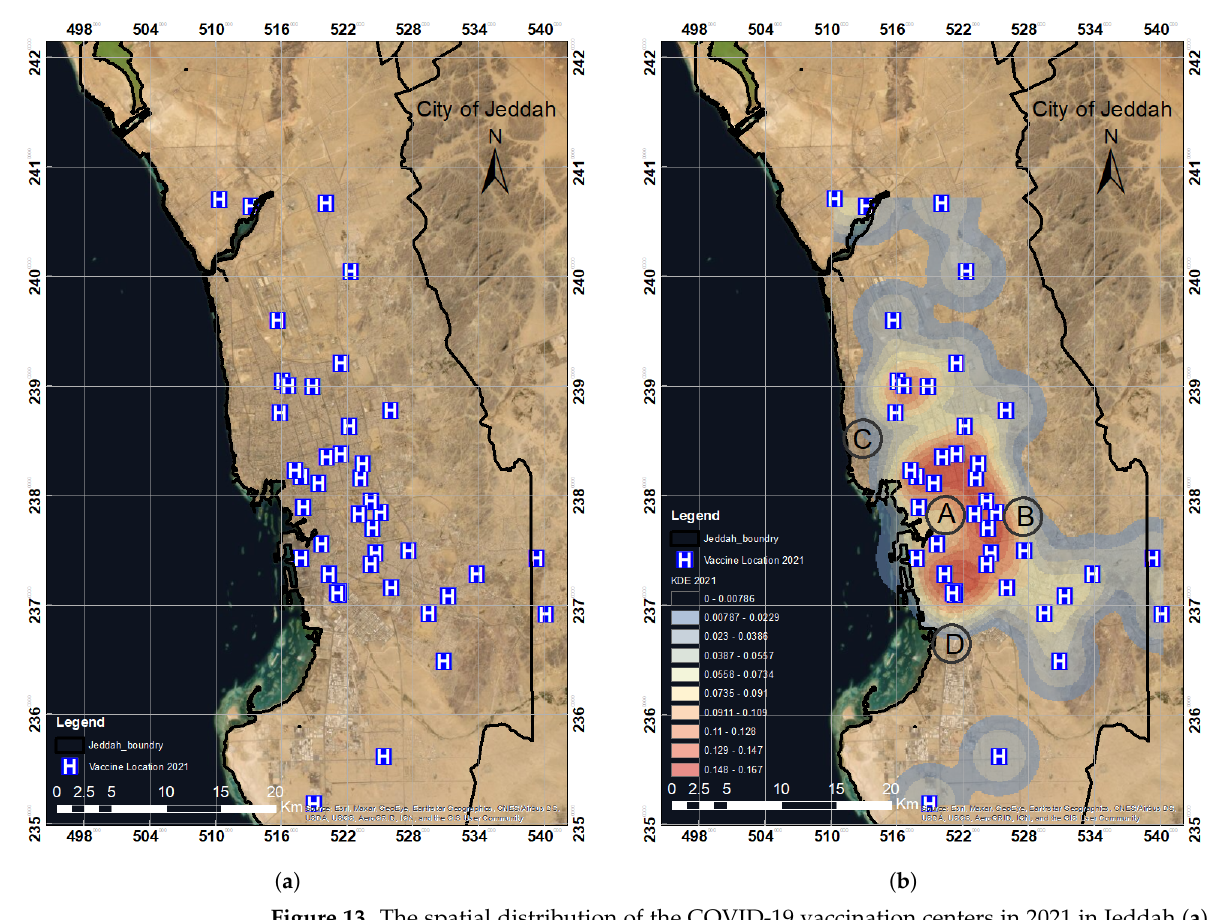
Figure 13. The spatial distribution of the COVID-19 vaccination centers in 2021 in Jeddah ( a ) and the KDE analysis for all 42 vaccination locations in Jeddah in 2021 ( b ), where zone A highlights the city center and zones B and C and D high demand points within uncovered regions. ( a ) Spatial distribution map of the vaccination centers in 2021. ( b ) KDE analysis of vaccination locations in